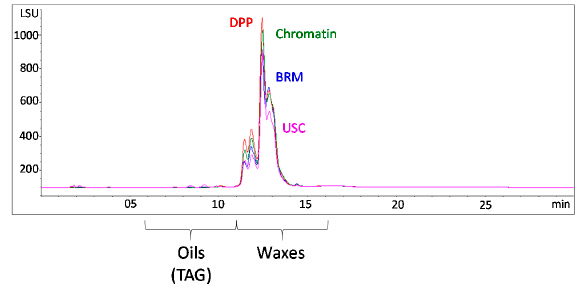
Figure 1. Chromatograms of the waxes extracted from the four sorghum grains: (1) Bob’s Red Mill (BRM, blue), (2) United Sorghum Checkoff (USC, pink), (3) DuPont Pioneer (DPP, red), and (4) Chromatin (green) Oils (primarily triacylglycerol, TAG) eluted between 6-11 min and waxes between 11–16 min.